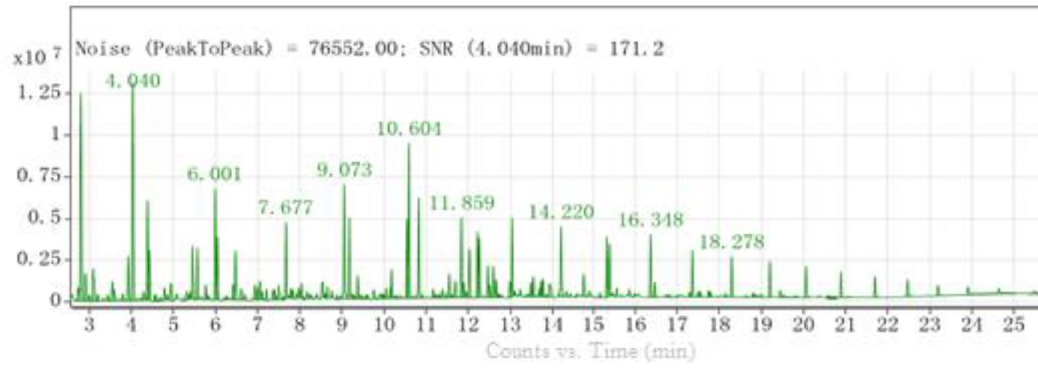
Fig. 1 The GC–MC spectrometry of crude oil Table 2 The retention time, peak area, the name of the compound and the molecular formula and the proportion of the main compounds of crude oil